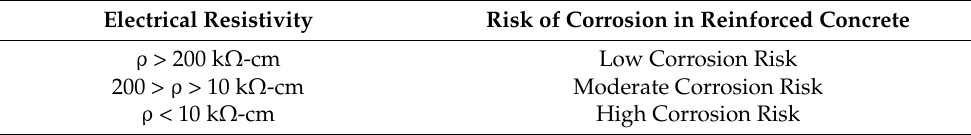
Table 4. Electrical resistivity in concrete and risk of corrosion